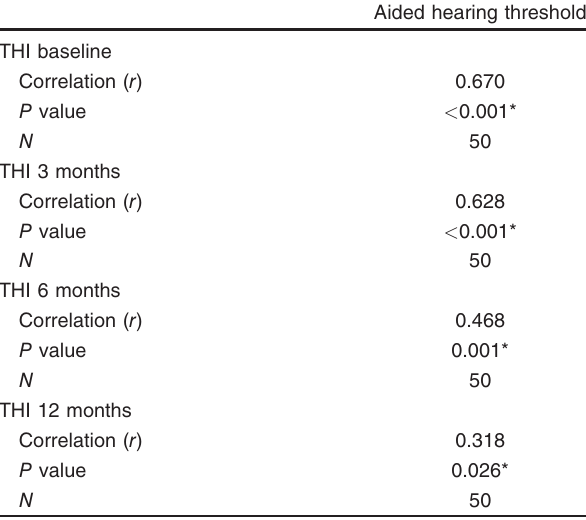
Table 5 Correlation between average aided hearing thresholds and each of Tinnitus Handicap Inventory baseline, at 3, 6, and